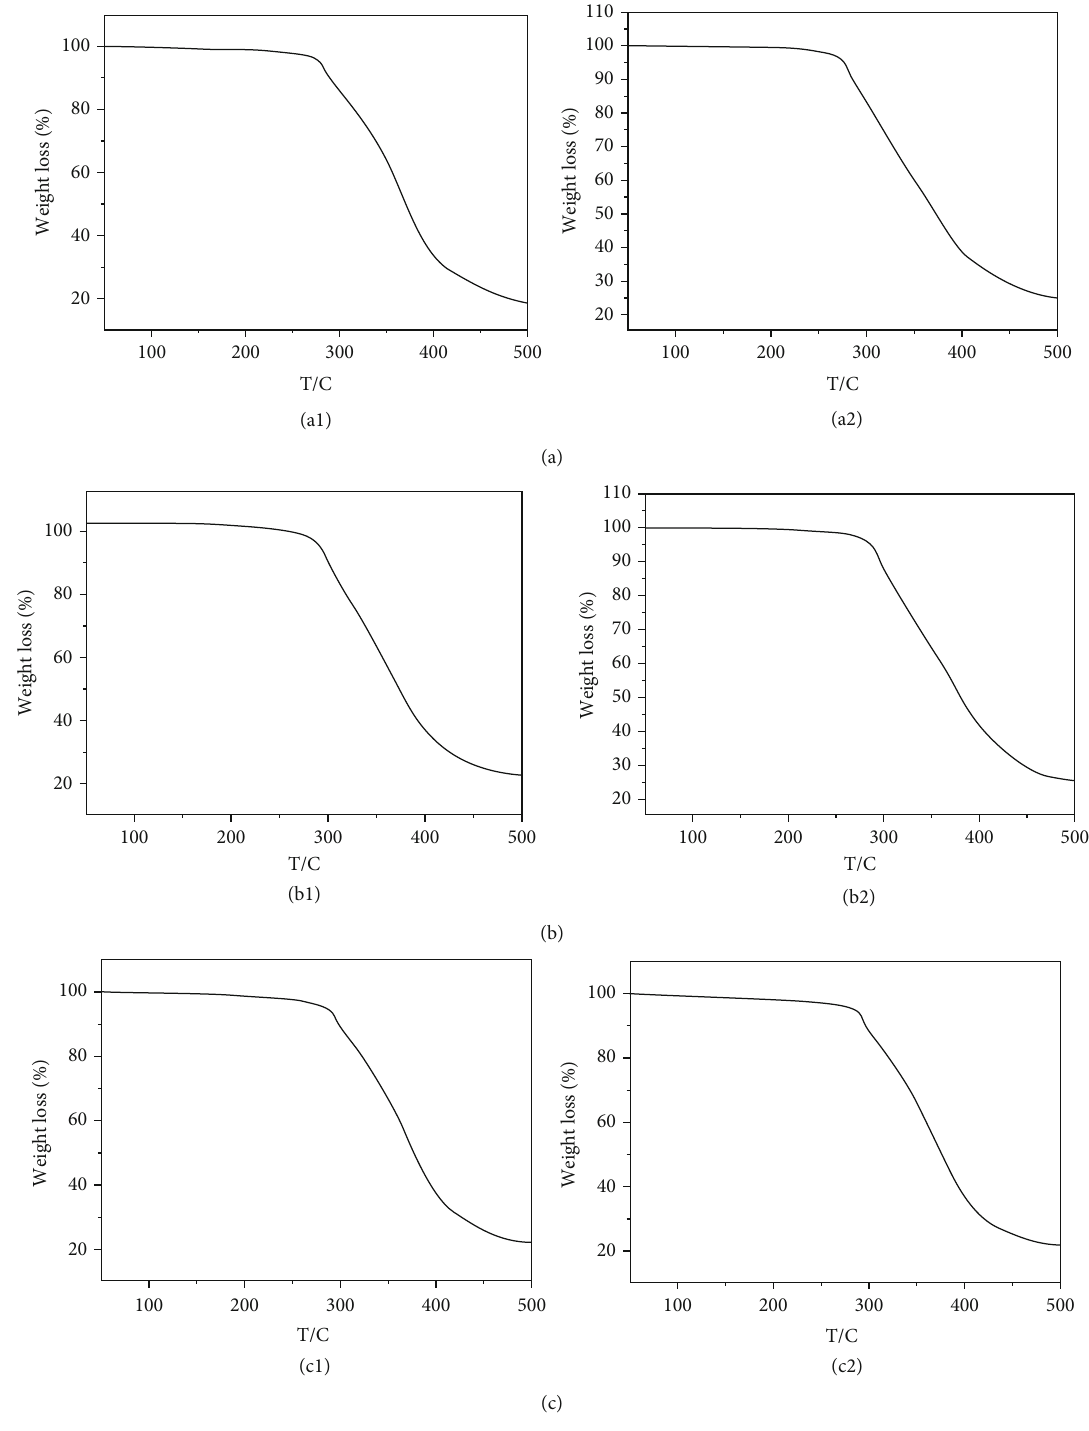
Figure 6: TG curves in N